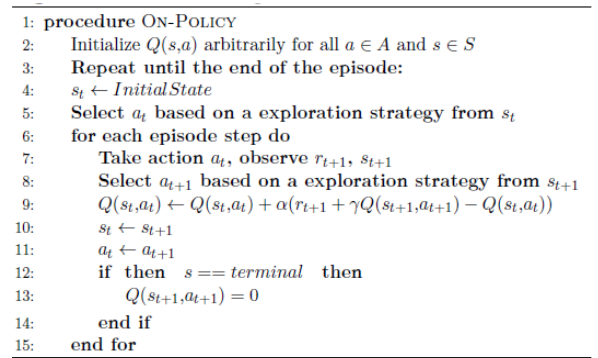
Figure 8. SARSA-learning